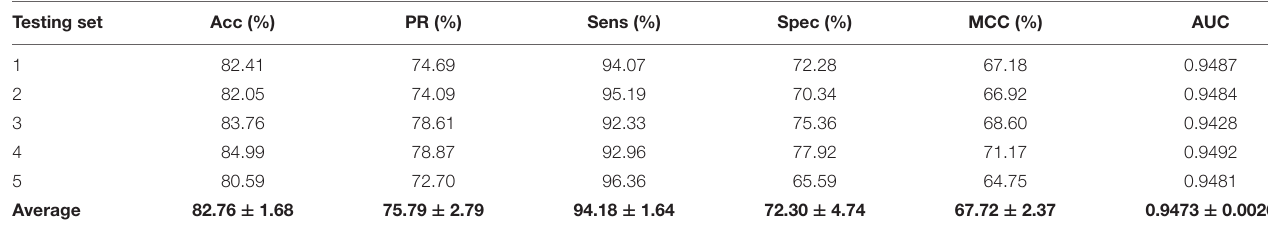
TABLE 8 | Five-fold CV results performed on the human dataset by the proposed model. Testing